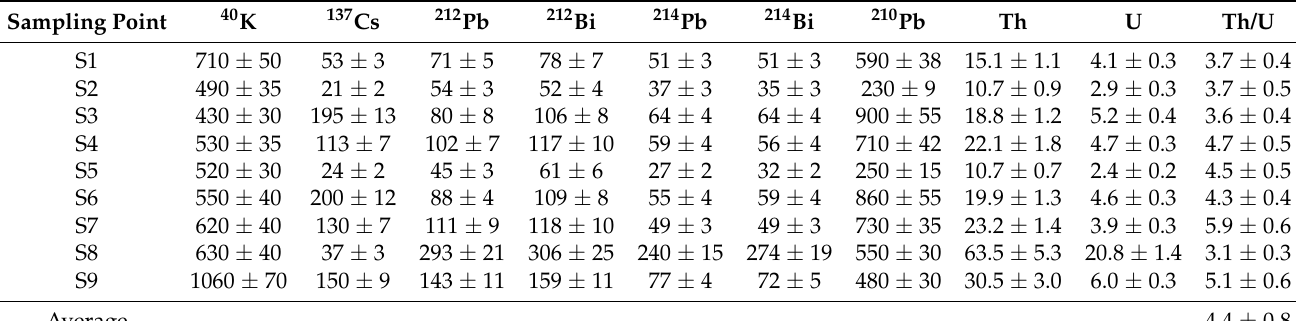
Table A3. The distribution of activity concentration of investigated radionuclides (in Bq/kg) as well as the corresponding mass fractions of Th and U (in